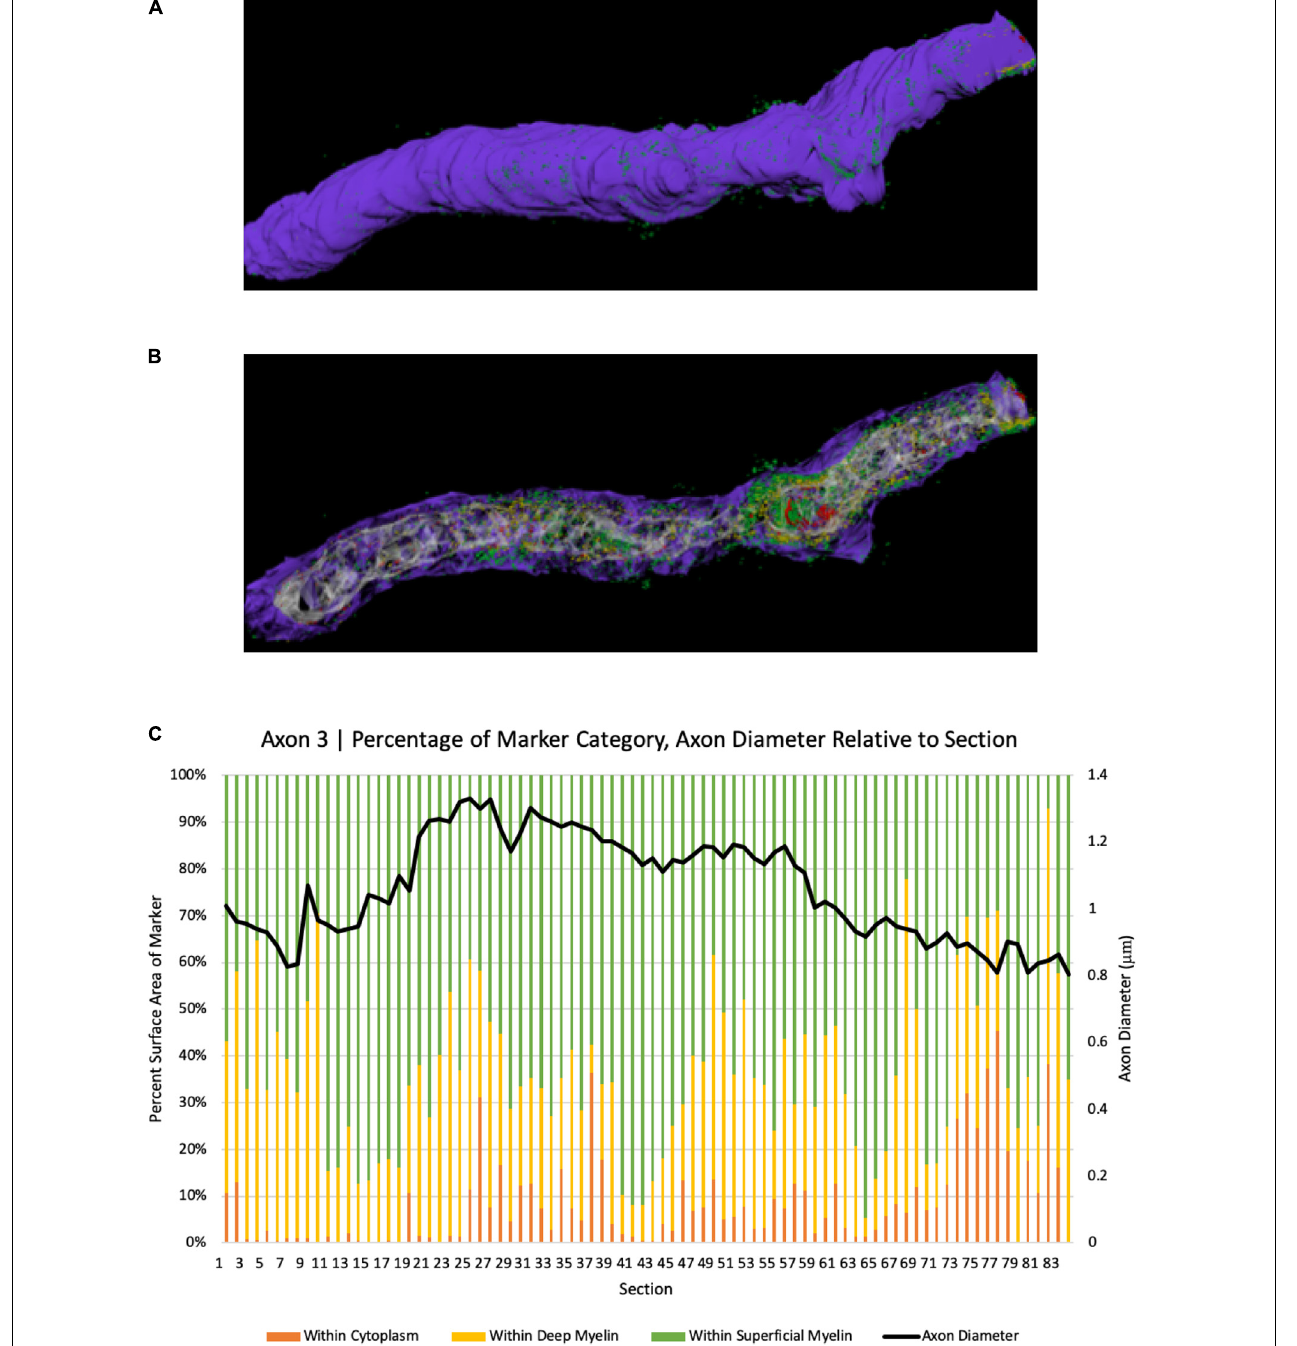
FIGURE 4 | 3D reconstruction of BCAN labeling in a single axon segment. (A) Single axonal segment (Axon 3) 11.63 µ m long, depicts the outside aspect of the axon. Reconstruction shows the same axon, electronically transected along its longitudinal axis to show the distribution of BCAN in the cytoplasm (red), beneath and between the myelin sheaths (B) . (C) Quantitative analysis of axon diameter and marker category percentage for each section. Y -axes depict percent surface area of BCAN labeling in each axonal compartment category (left); legend: Purple, myelin; white-gray, cytoplasm; red, within cytoplasm; yellow, marker within deep myelin; green, marker within superficial myelin, and the corresponding axon diameter of each section in microns (right), for each transected axon section analyzed as indicated on the x -axis.